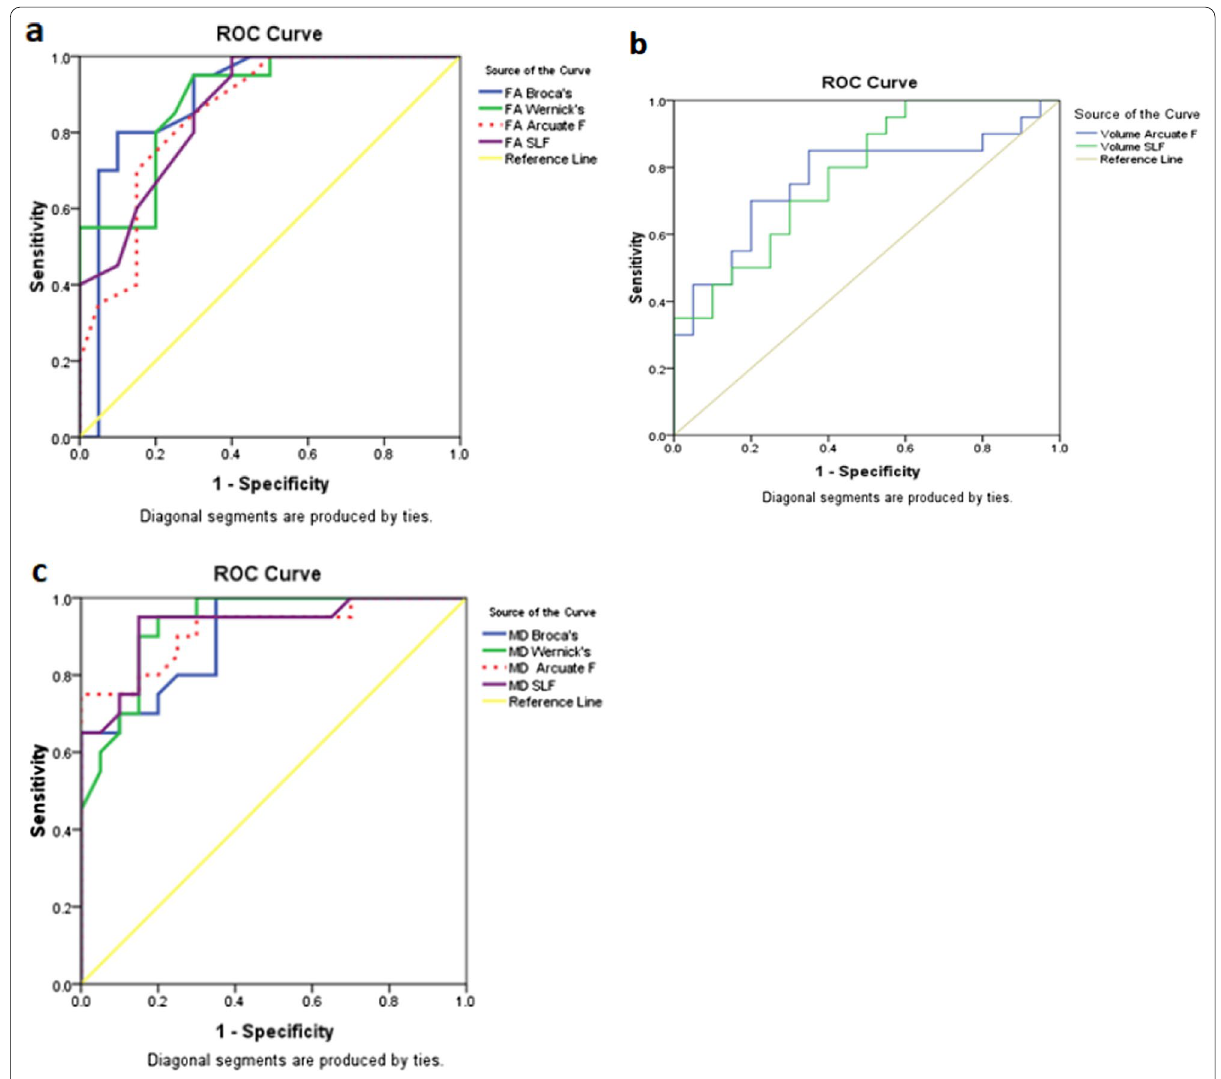
Fig. 4 ROC curve of a FA of AF and SLF, b volume of AF and SLF, c MD of AF and